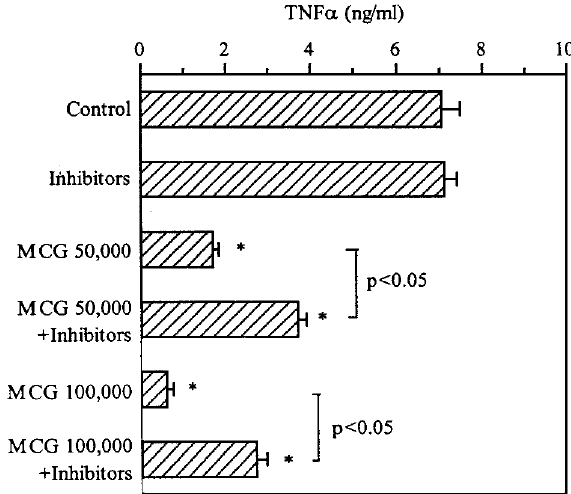
FIG. 7. Effect of protease inhibitors on TNF a degradation by MCG. Mouse recombinant TNF a was incubated with the indicated doses of MCG in cell culture medium for 24h. MCG were incubated with the protease inhibitor mixture at 37°C for 2h before being added to TNF a . The TNF a levels were assayed by ELISA. Values presented are the mean ± SEM of quadruplicate determinations. The protease inhibitor mix- ture contains 2.5mM PMSF, 5 m g/ml pepstatin A, 50 m g/ml each of trypsin inhibitor, leupeptin and aprotinin. This is representative of three experiments.* P <0.05 vs.